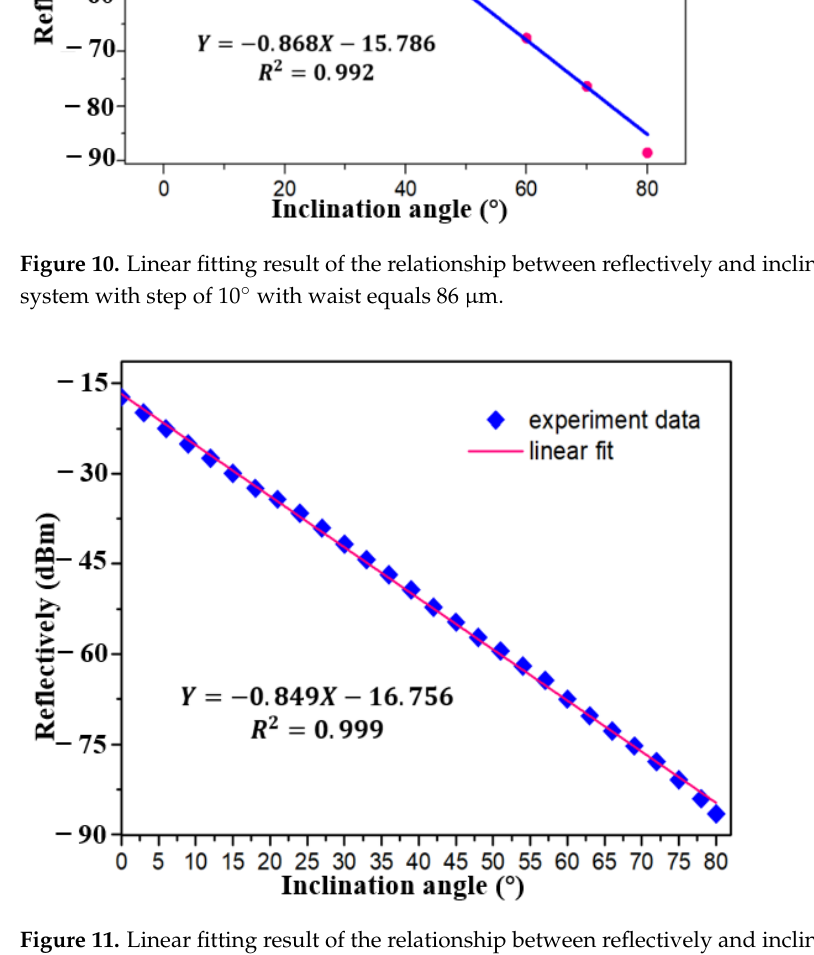
Figure 11. Linear fitting result of the relationship between reflectively and inclination angle in FRL system with step of 3°.